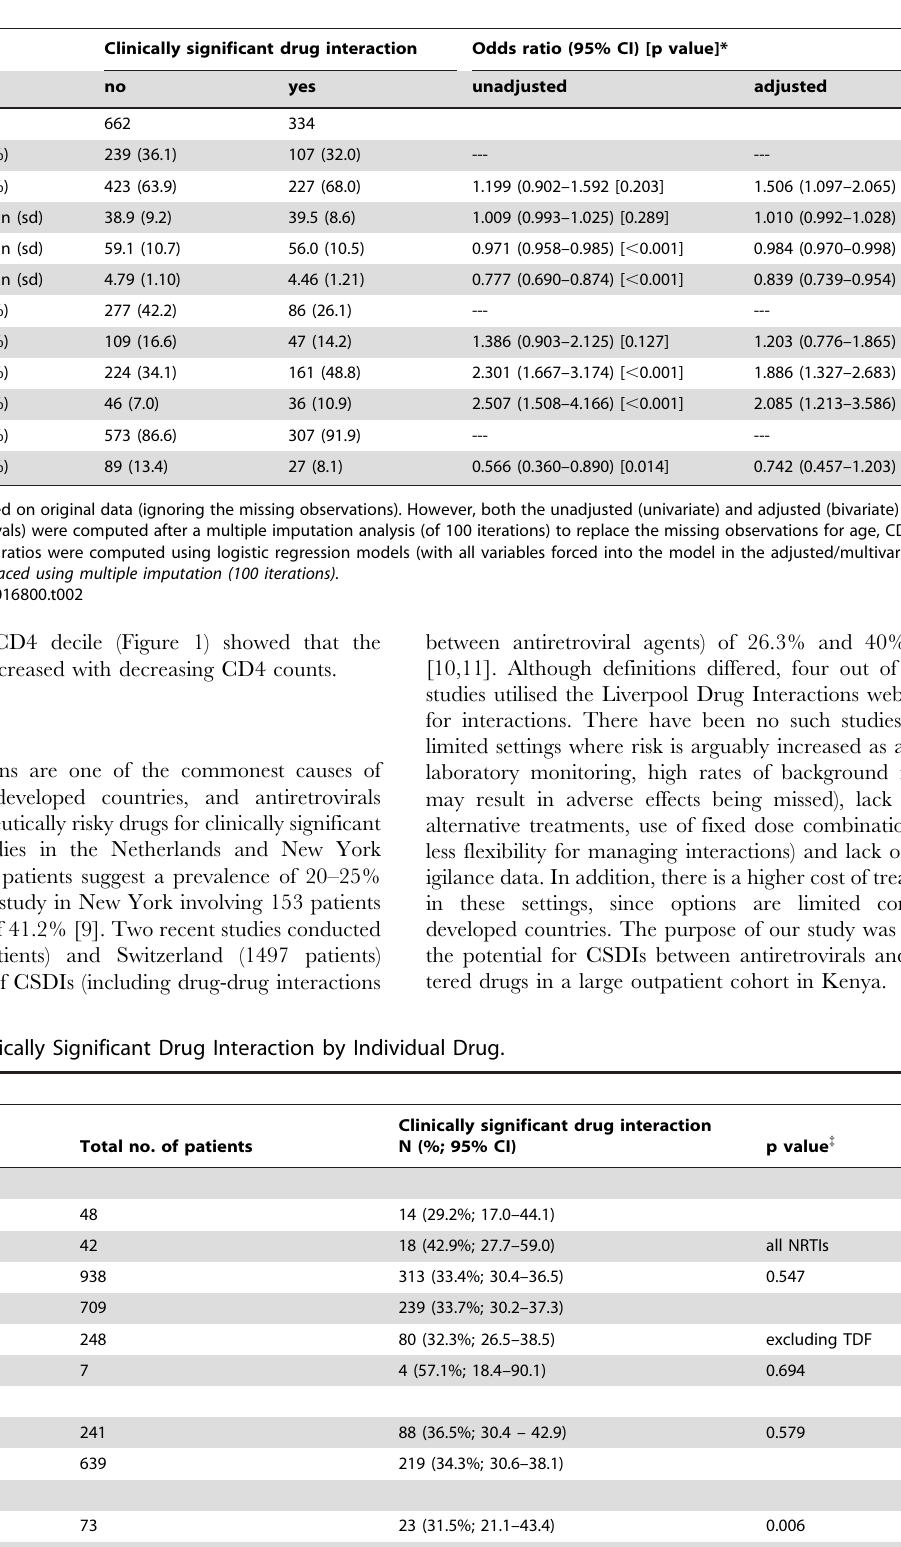
Table 2. Factors Associated with Risk for Developing a Clinically Significant Drug Interaction.